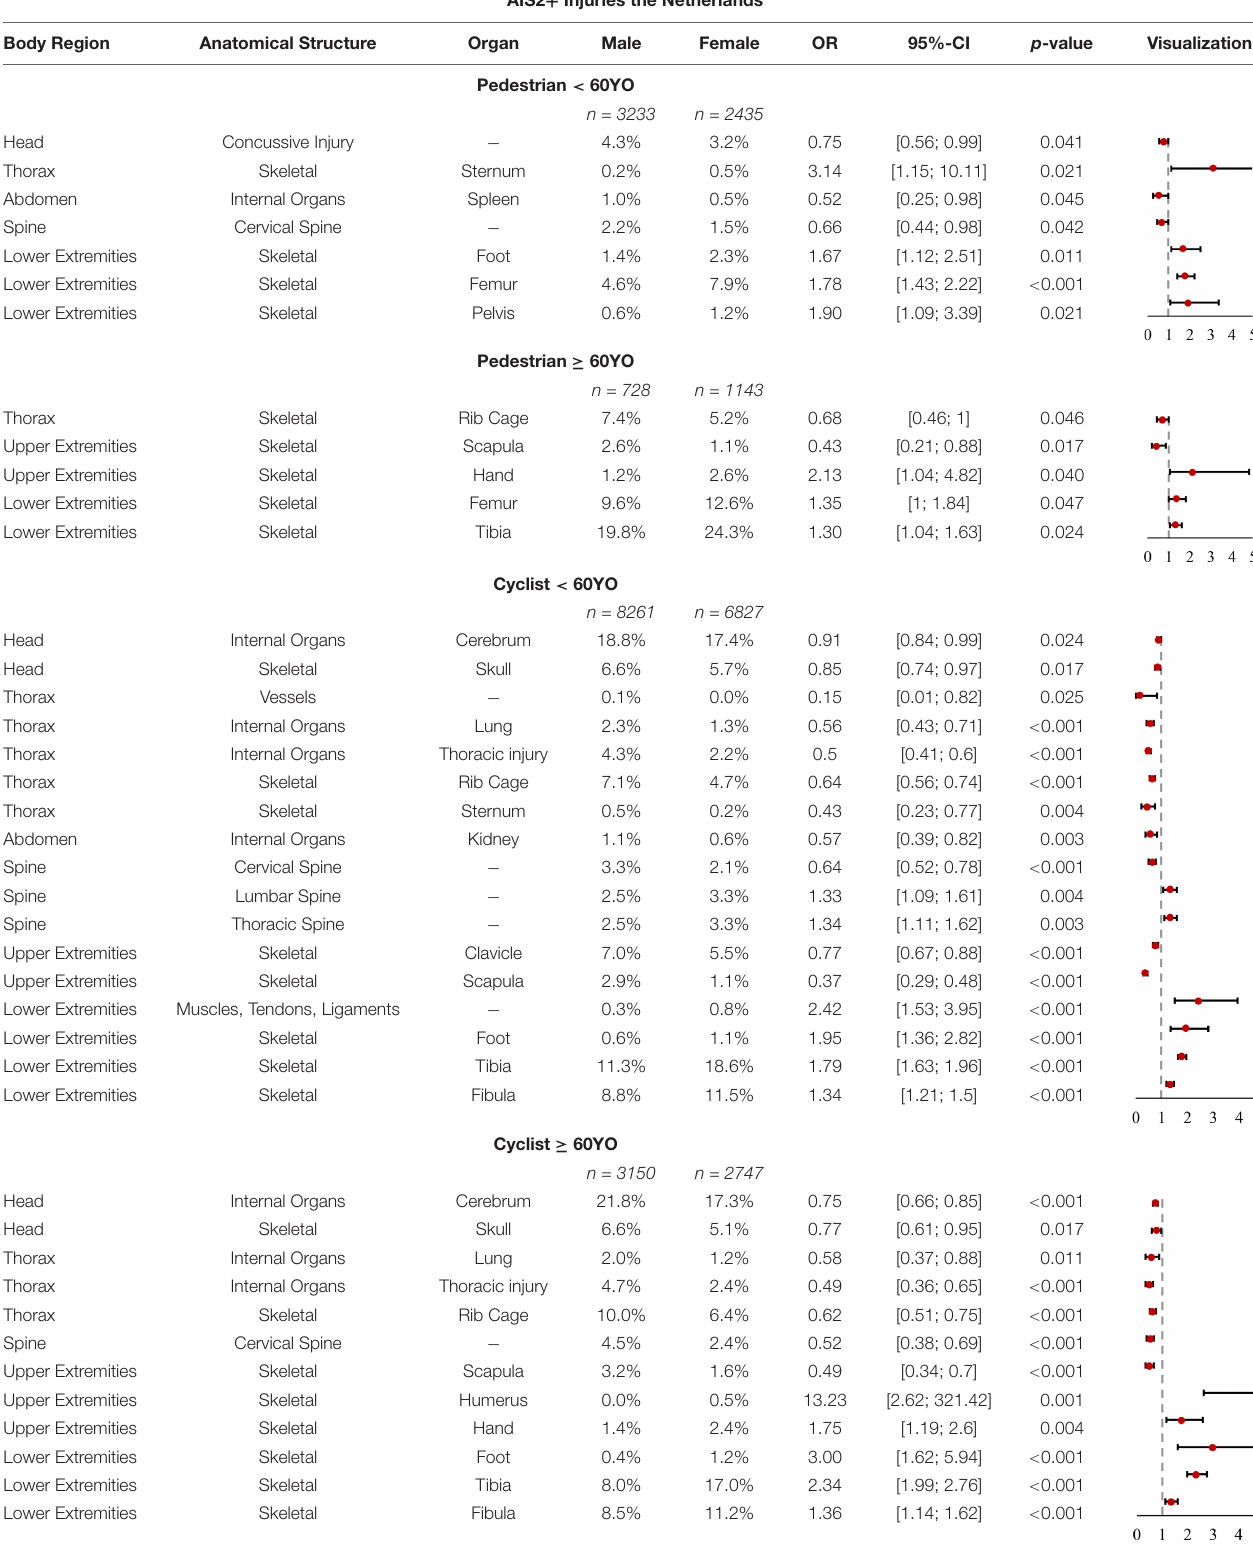
TABLE 8 | Share of AIS2 + and AIS3 + injuries with significant differences, OR and p -value in the Netherlands for pedestrians and cyclists < 60YO and ≥ 60YO. AIS2 + Injuries the